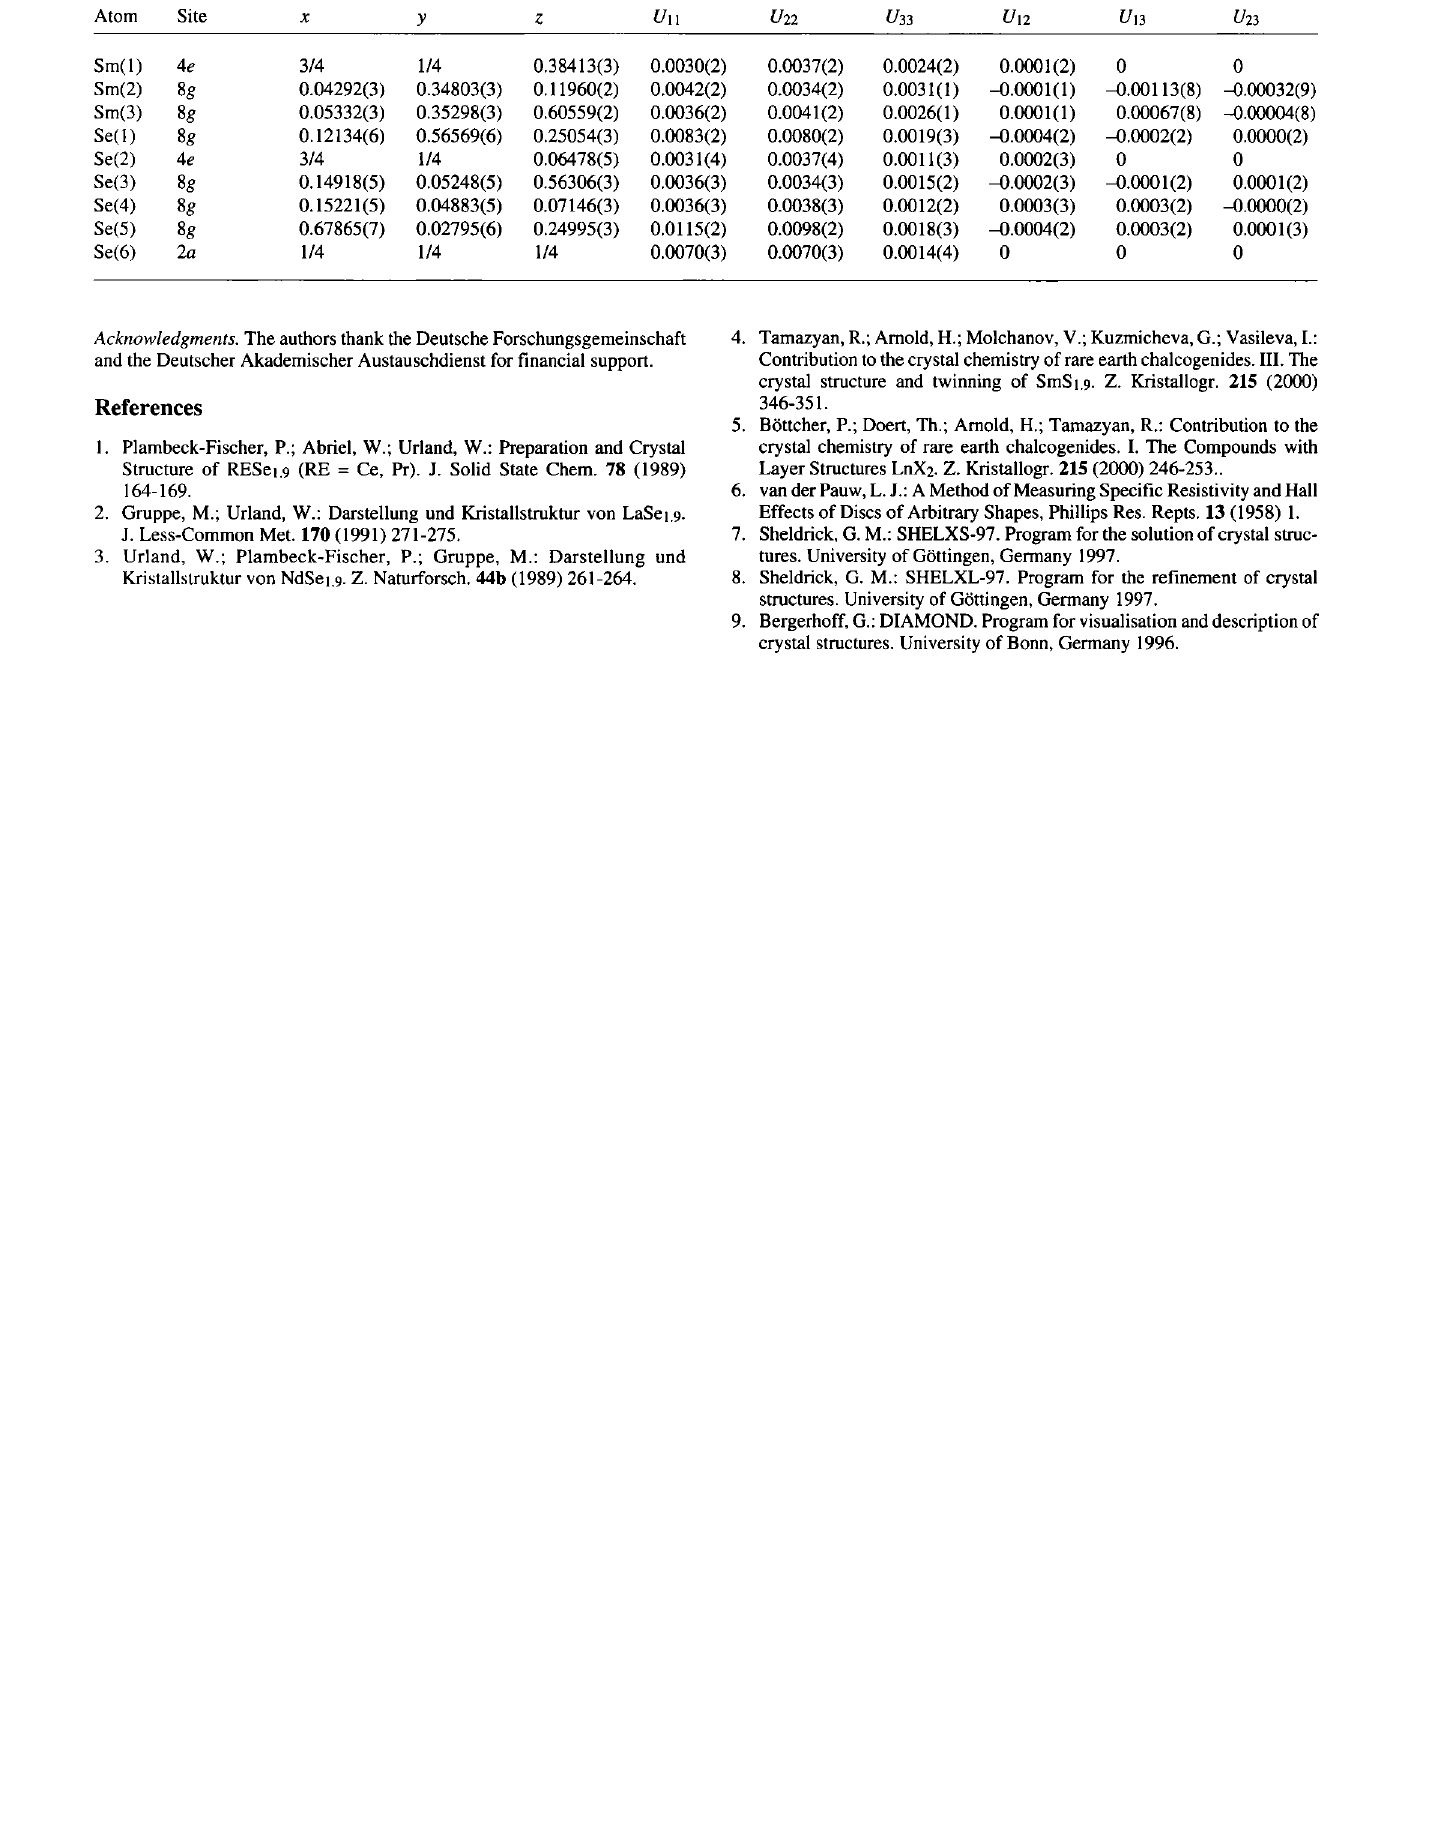
Table 2. Atomic coordinates and displacement parameters (in Ä 2